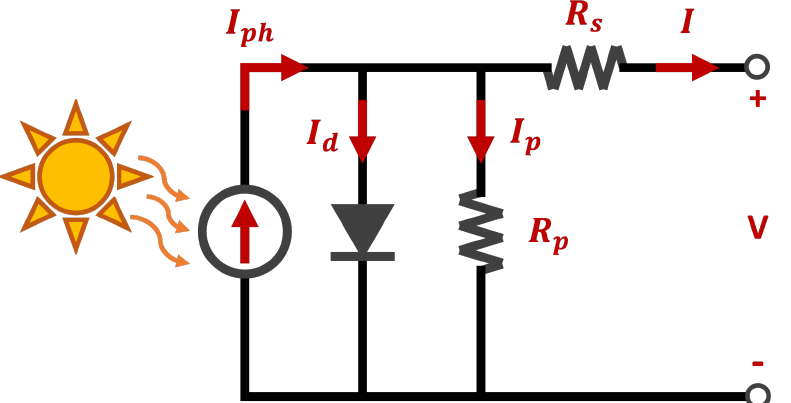
Figure 2. Electric diagram of the single-diode equivalent model with ohmic losses for PV